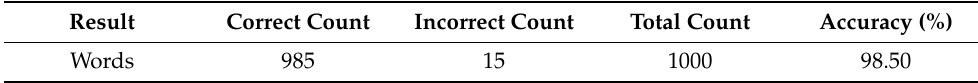
Figure 15. A simple user interface for the system. Table 6. Segmentation results.